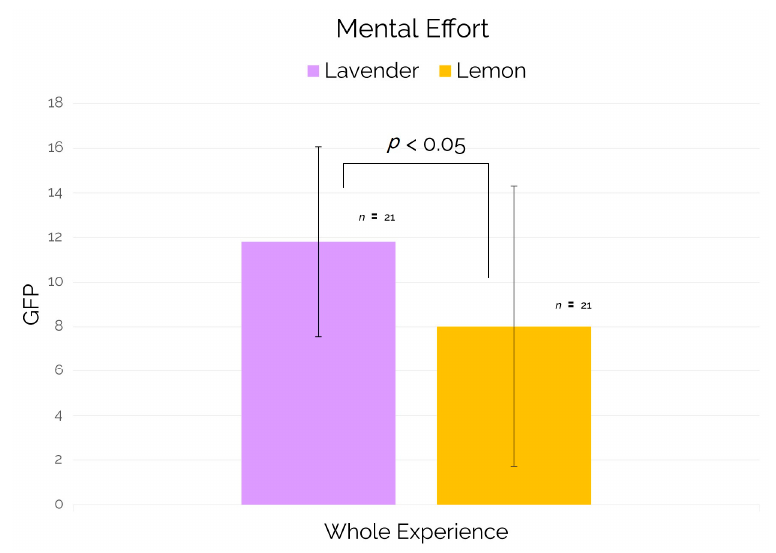
Figure 7. Mental Effort for the "whole experience" time segment.